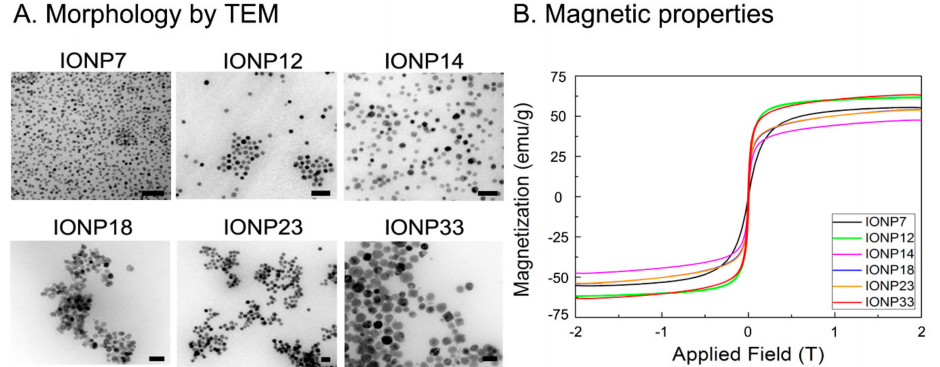
Figure 3. ( A ) Morphology characterization by TEM and ( B ) magnetic characterization by VSM of all IONPs with different core sizes. Scale bar: 50